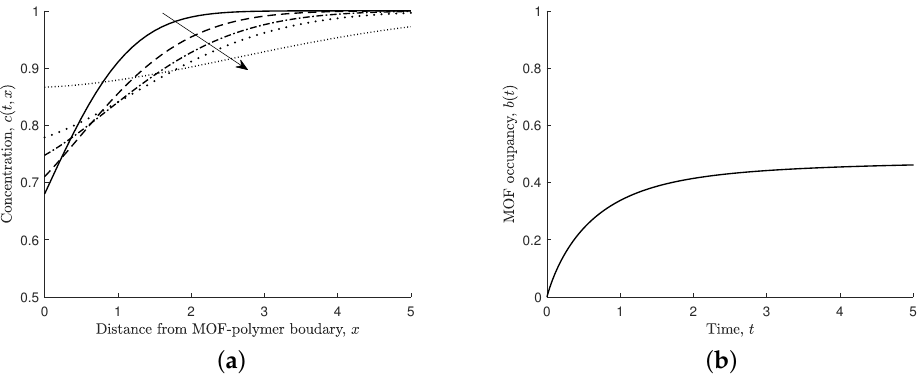
Figure 4. ( a ) Non-dimensional concentration of ferric ions in solution, c ( t ,0 ) . Arrow indicates increasing time, t = 0.5,1,1.5,2,5. ( b ) Non-dimensional MOF occupancy, b ( t ) . Here, s 1 = s 2 = s 3 = s 4 = 1.